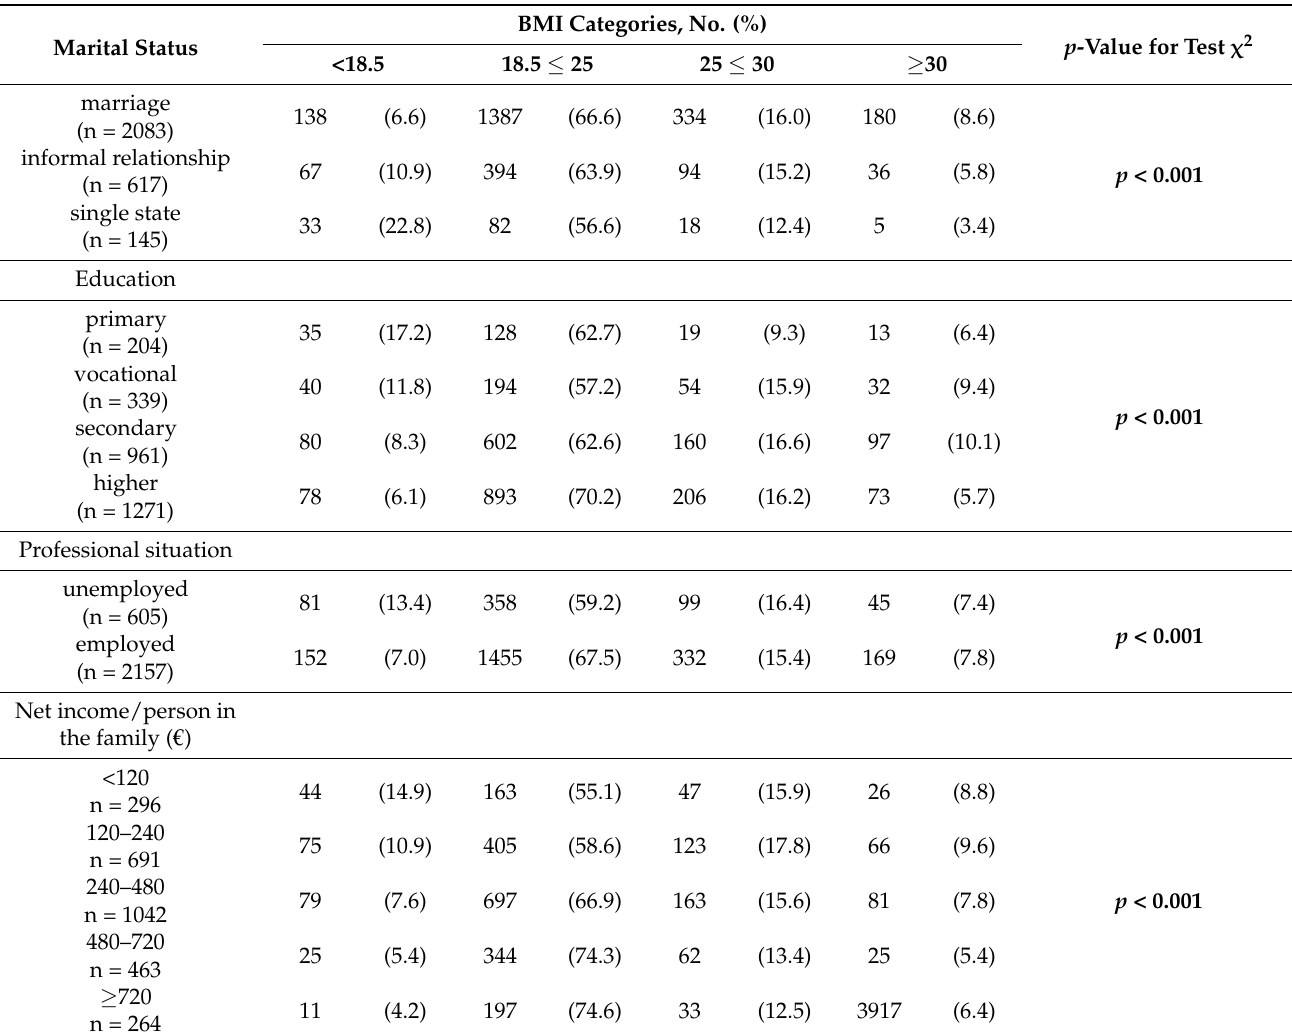
Table 2. Early pregnancy BMI depending on selected socioeconomic